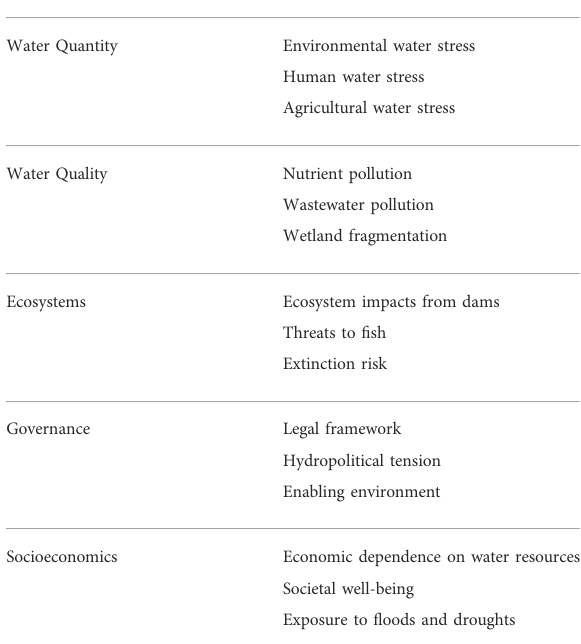
TABLE 2 The indicators and indexes of water risk